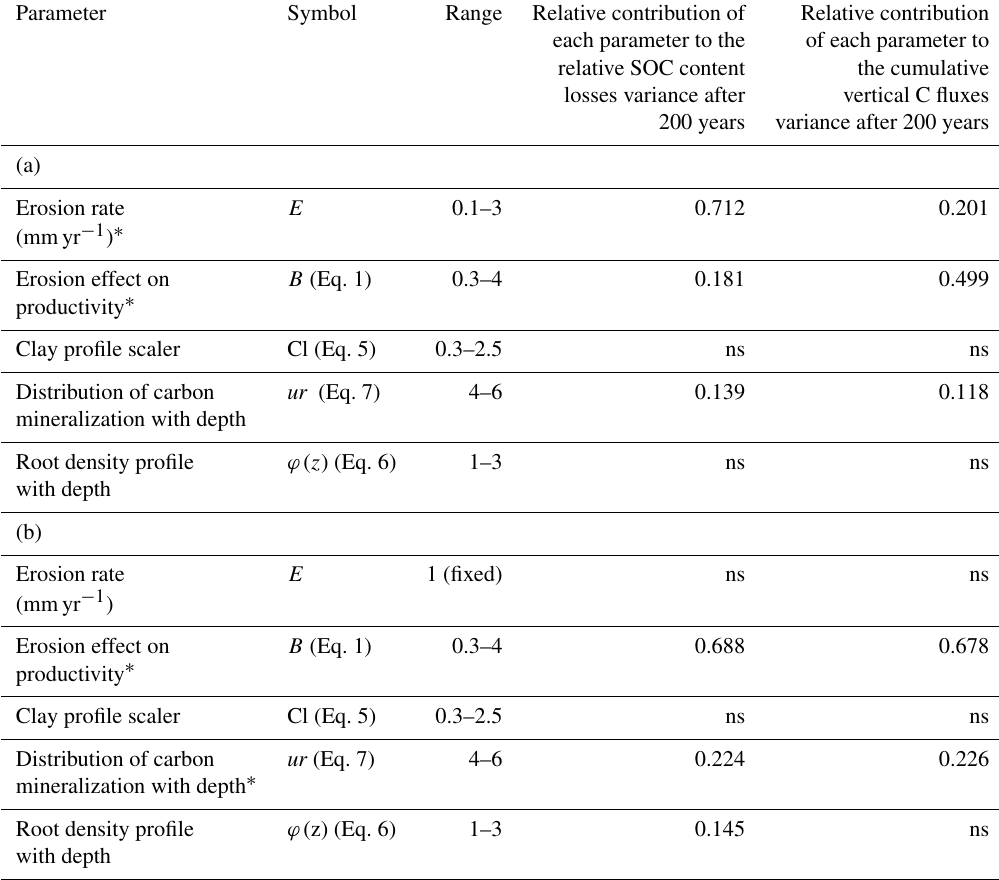
Table 3. Selected parameters, range of tested values and results of the FAST analysis. The FAST analysis results can be interpreted as the relative contribution of each parameter variability to the total variance of the selected output, i.e. the relative SOC loss compared to the initial SOC content and the cumulative vertical C fluxes at the end of the 200-year transient simulations. Table 3a represents analysis A where erosion intensity was allowed to vary while Table 3b represents analysis B where a constant erosion rate was used; “ns” stands for “non-significant”. The sum of the contribution to the global variance may exceed 1 when two or more variables are